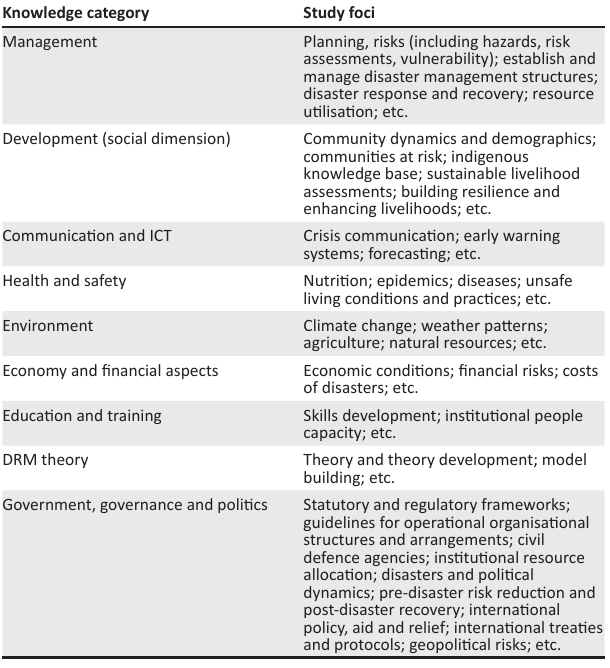
TABLE 1: Knowledge categories of disaster risk management. Knowledge category Study